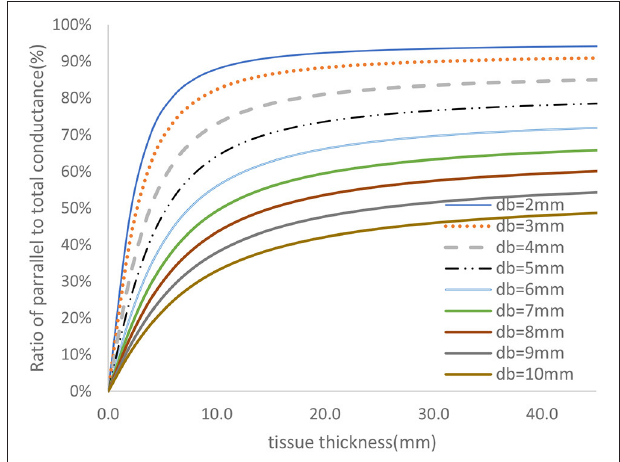
TABLE 5 | Variation of the ratio of parallel conductance to the total conductance with respect to TR, predicted by the model.